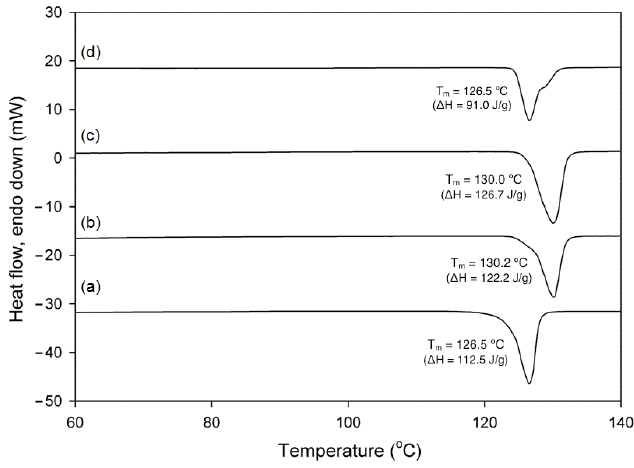
Figure 5. DSC thermograms showing the melting behaviors of AD/SUC